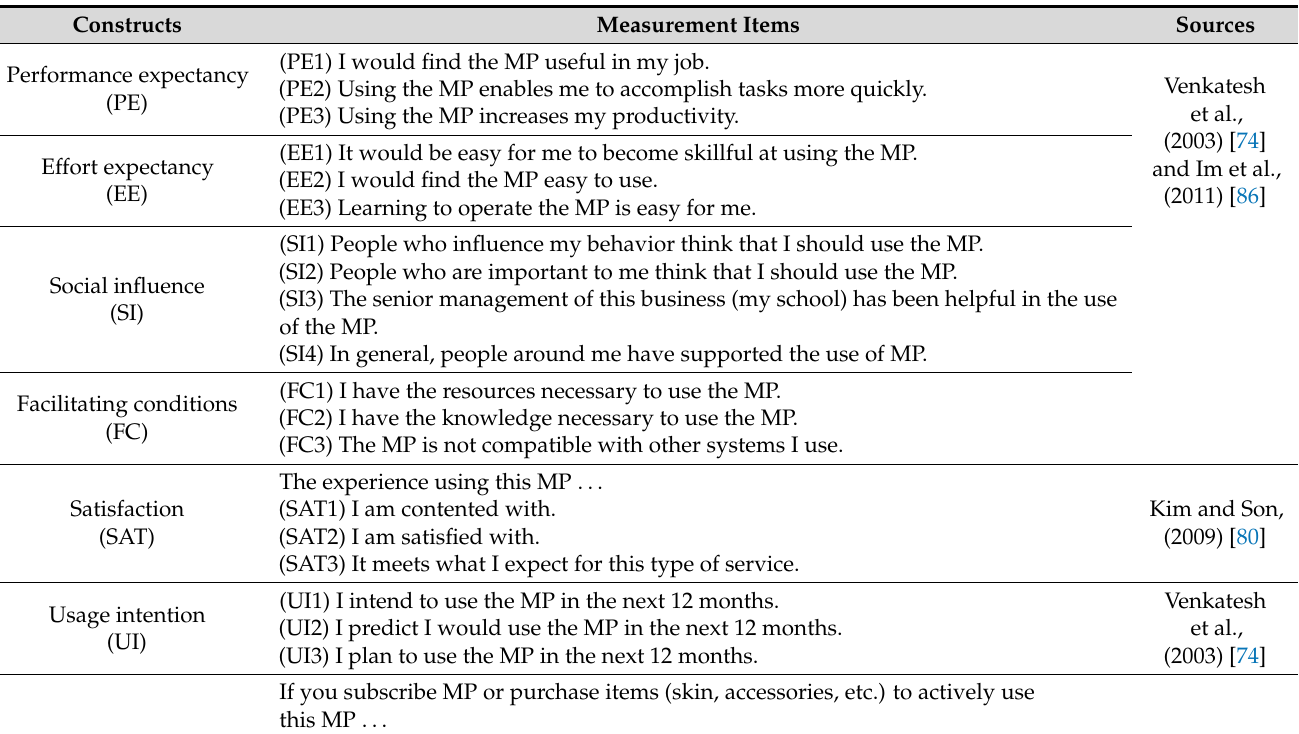
Table 2. Measurement items and survey